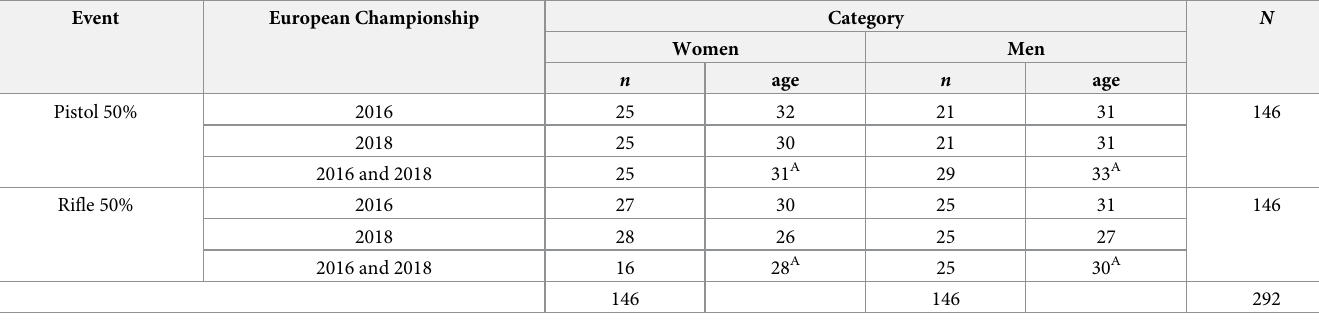
Table 1. Sample descriptive data. Event